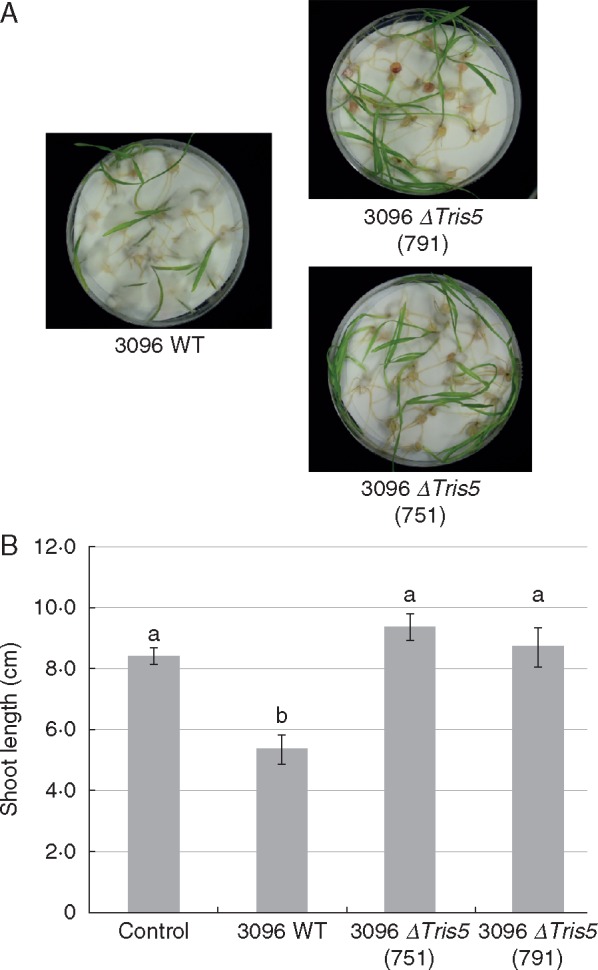
Reduction of virulence in Tri5 F. pseudograminearum knockout mutants. (A) Representative infection assays with the parental (CS3096) isolate and two independent mutants. (B) Shoot length is used as a measure of isolate virulence. Plants inoculated with the CS3096 parental strain are significantly shorter than the plants inoculated with the TRI5 mutants. Student’s t-testing was applied to determine statistically significant differences between mean values.